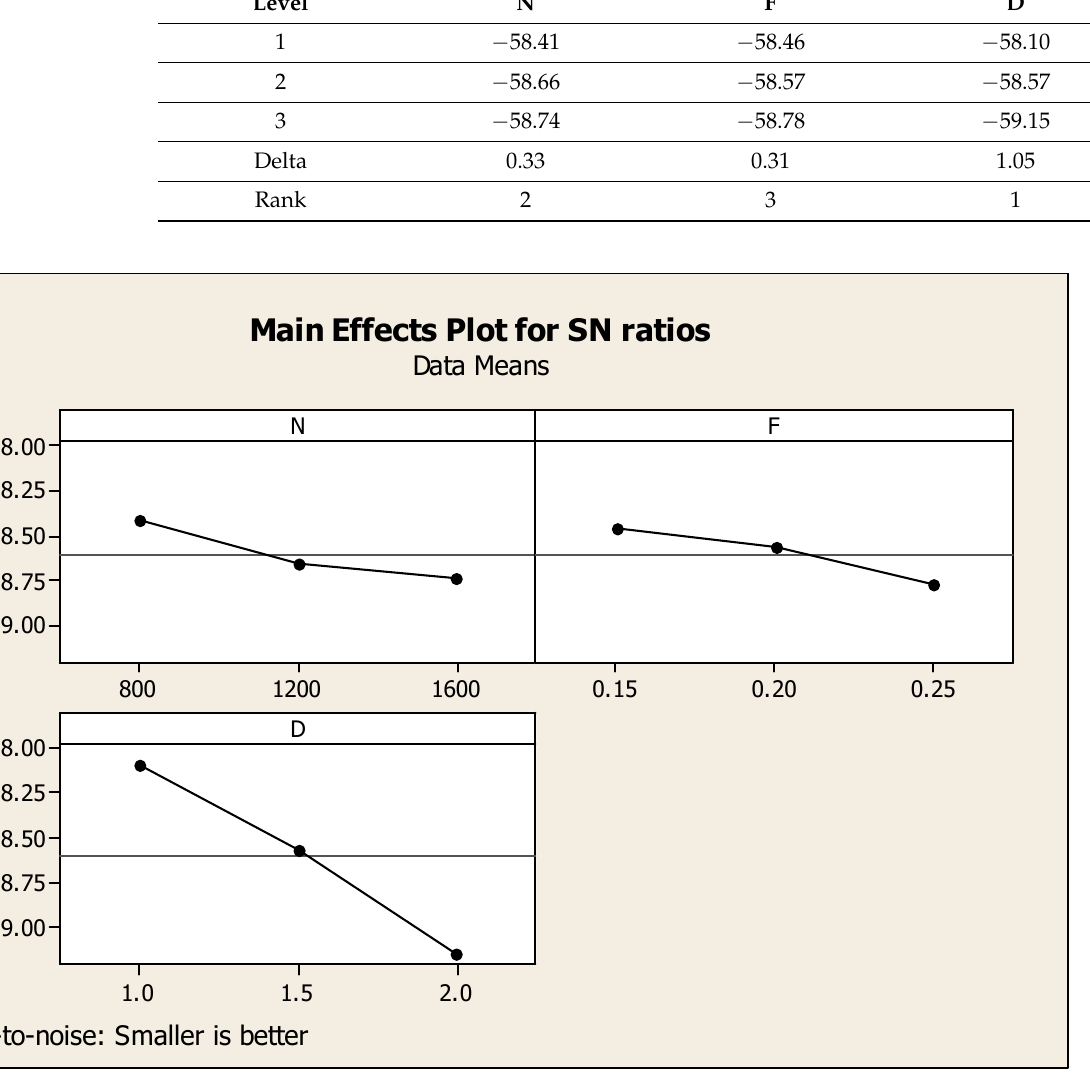
Figure 9. CF major effects diagram with respect to signal-to-noise ratios. Table 6. Taguchi investigation details of CF vs. N, F, and D.